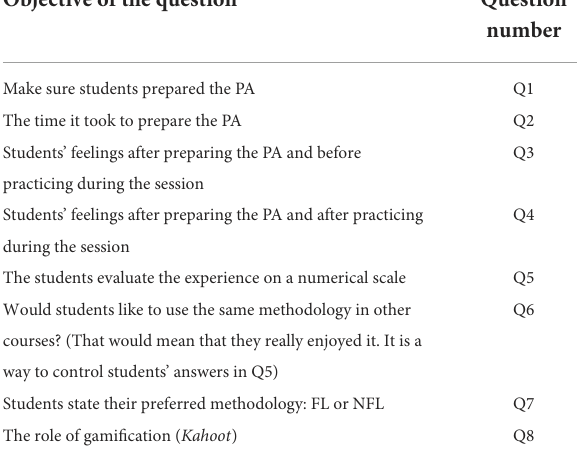
TABLE 2 Overview of the